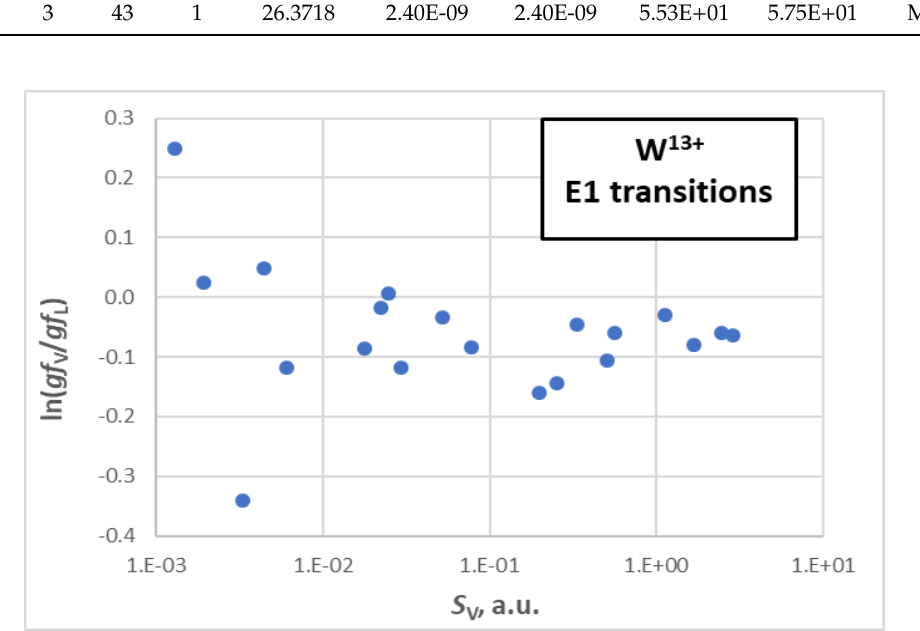
Figure 5. A comparison of the velocity and length forms of oscillator strength for a few of the strongest transitions (E1) of W 13 + . In the 4f 13 5s 2 2 F 7 / 2 and 4f 13 5s 2 2 F 5 / 2 levels, the mixing is very low, and their labeling is unambiguous. We would also like to mention that mixing among some of the levels is strong in our